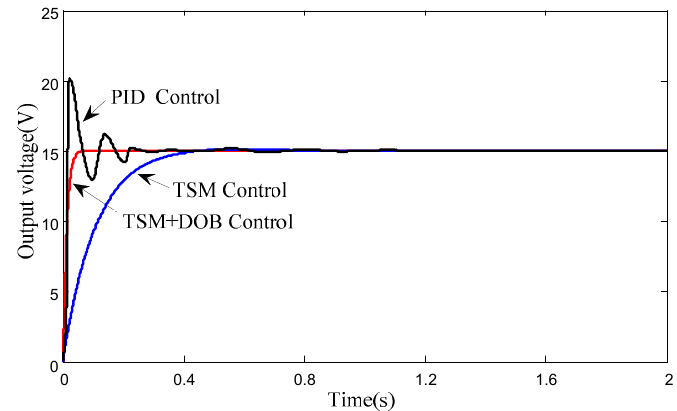
Figure 3. Simulated start ‐ up waveform of output voltage in the absence of disturbance.